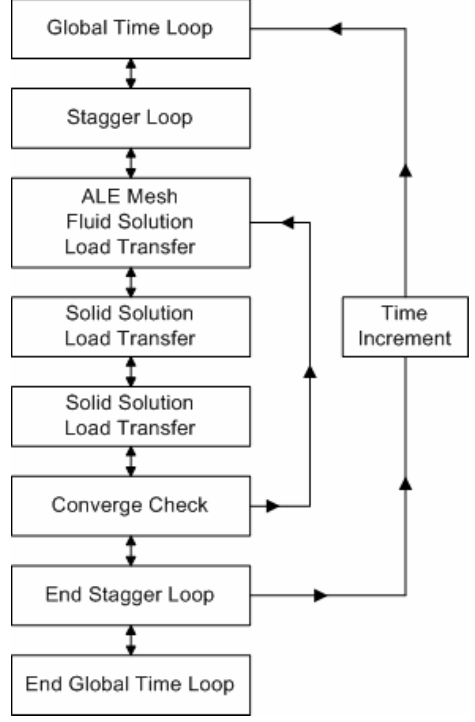
Fig. 5. Lagrangean-Eulerian